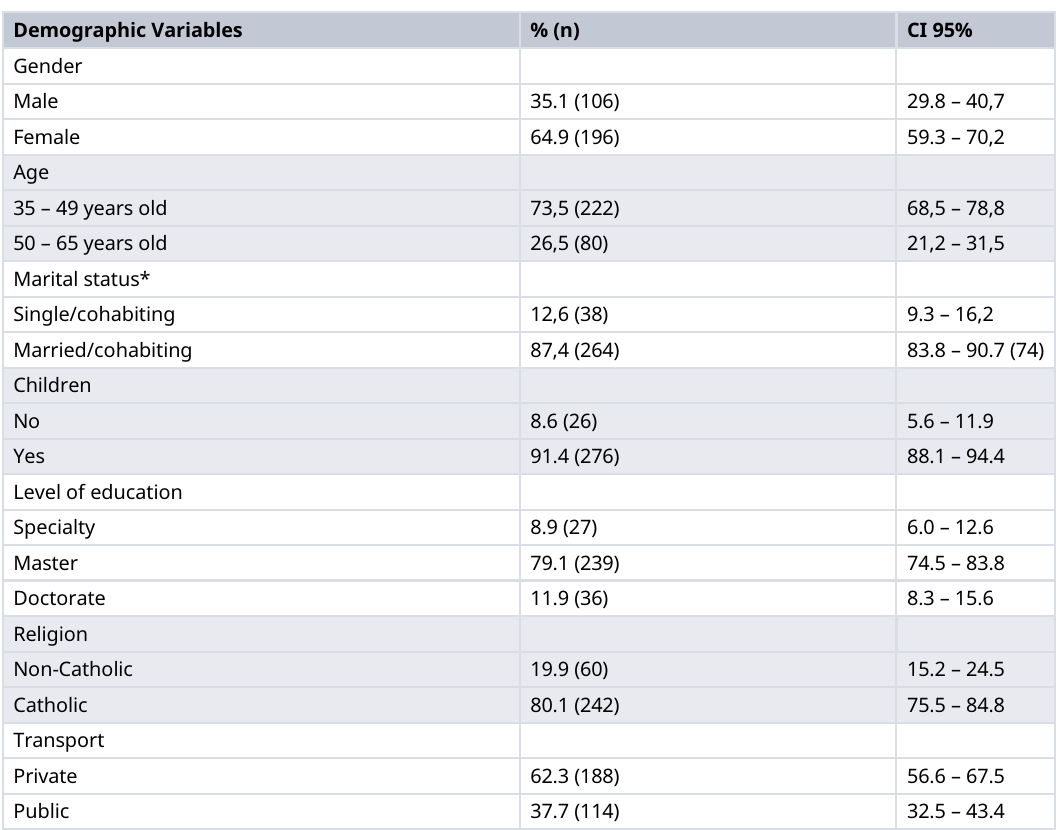
Table 1. Demographic characteristics of the